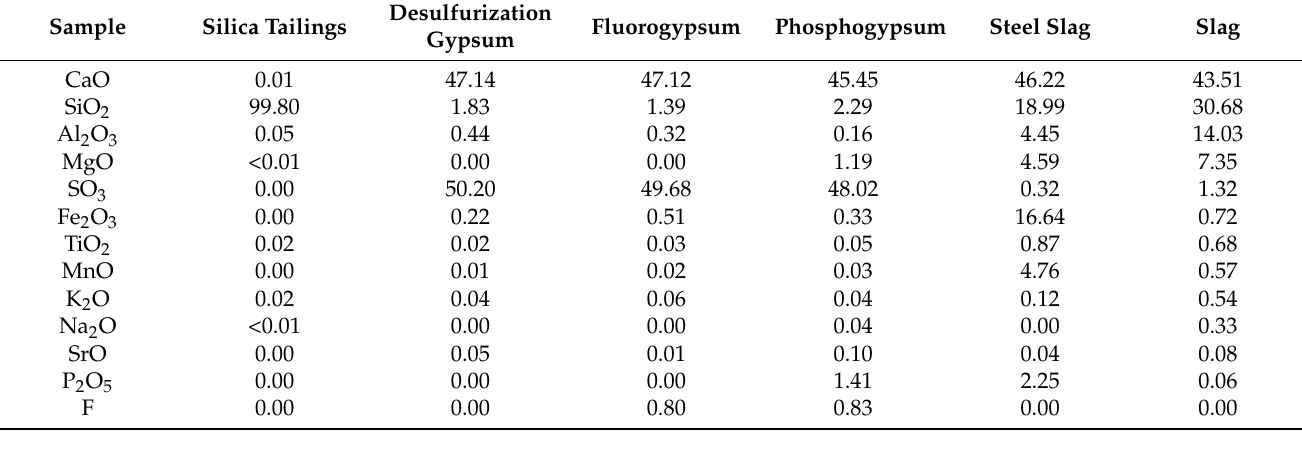
Table 1. Chemical composition of raw materials used in the experiment.